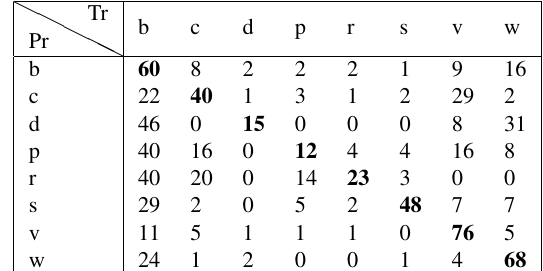
Figure 4: The classification accuracy of each class of the RDF classifier with mean shift and the accuracy with respect to the numbers of the decision trees. Left : the classification accuracy of each class on all feature sets. Right : the classification accuracy with respect to the numbers of the decision trees for training. Table 6: Accuracy of RDF classifier with the mean shift seg- mentation on the eTRIMS 8-class dataset. The confusion ma- trix shows the classification accuracy for each class (rows) and is row-normalized to sum to 100%. Row labels indicate the true class (Tr), and column labels the predicted class